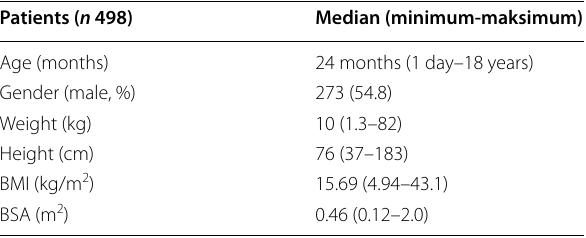
Table 2 Types of anesthesia and catheter used in patients